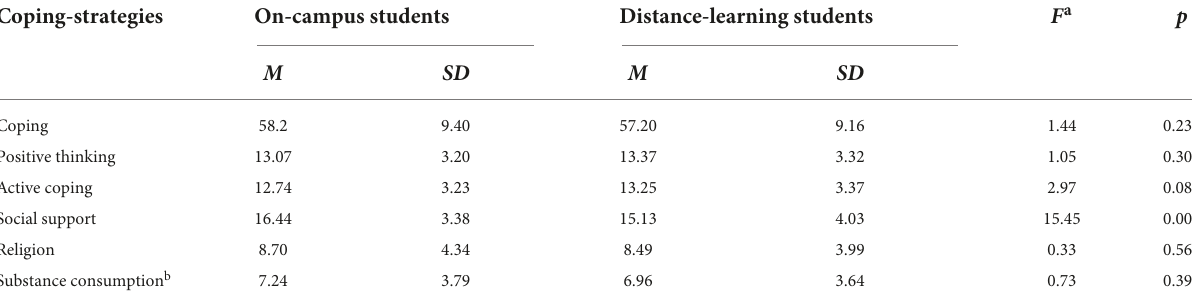
TABLE 5 Means and standard deviations of each SCI-coping subscale as well as results of the ANOVA for on-campus students and distance-learning students ( N = 500).